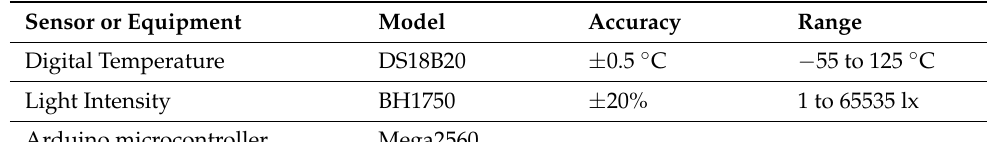
Table 4. Equipment specification.